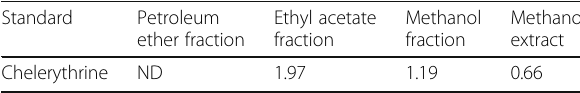
Table 1 Contents (mg/g) of chelerythrine in different fractions extracted from roots of T. asiatica